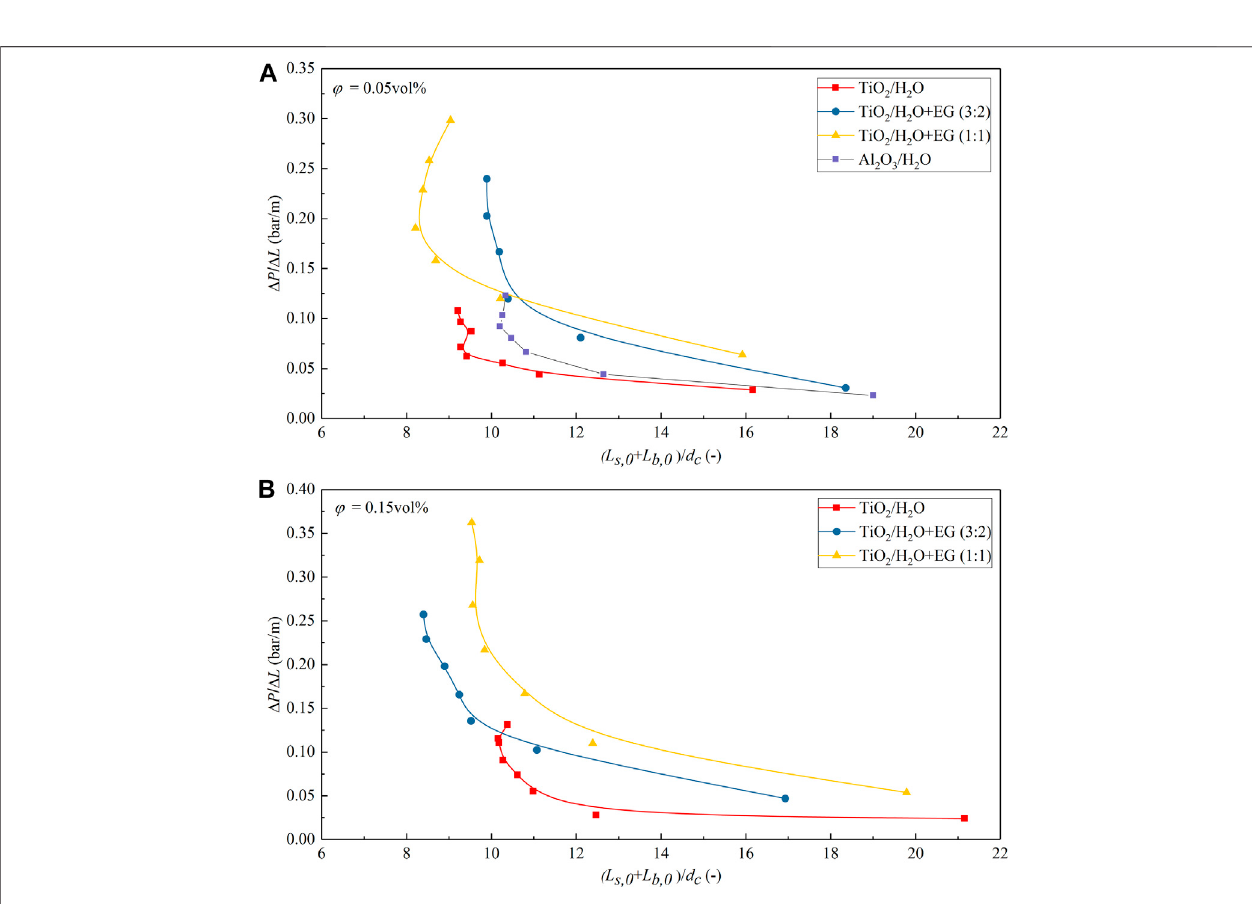
Frontiers in Chemical Engineering |